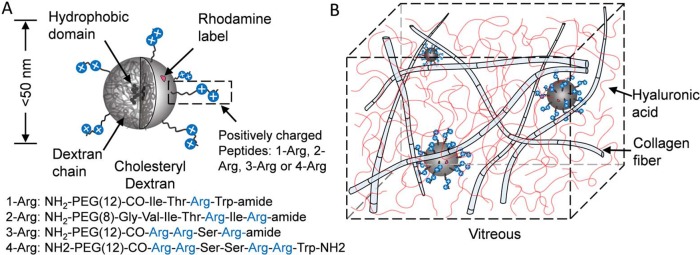
Schematic of the nanoparticles and drug delivery mechanism. (A) Particle structure. CDEX nanoparticle (less than 50 nm in diameter). Hydrophobic domains are inside the particle close to the core. Particles were labeled by rhodamine B with less than three molecules per particle. Three types of positively charged peptides were linked on the particle surface, with a density of 19 to 30 peptides per particle. (B) Particles are smaller than the vitreous fiber mesh. They are trapped in vitreous by ionic binding between peptides on particle surface and HA coils.